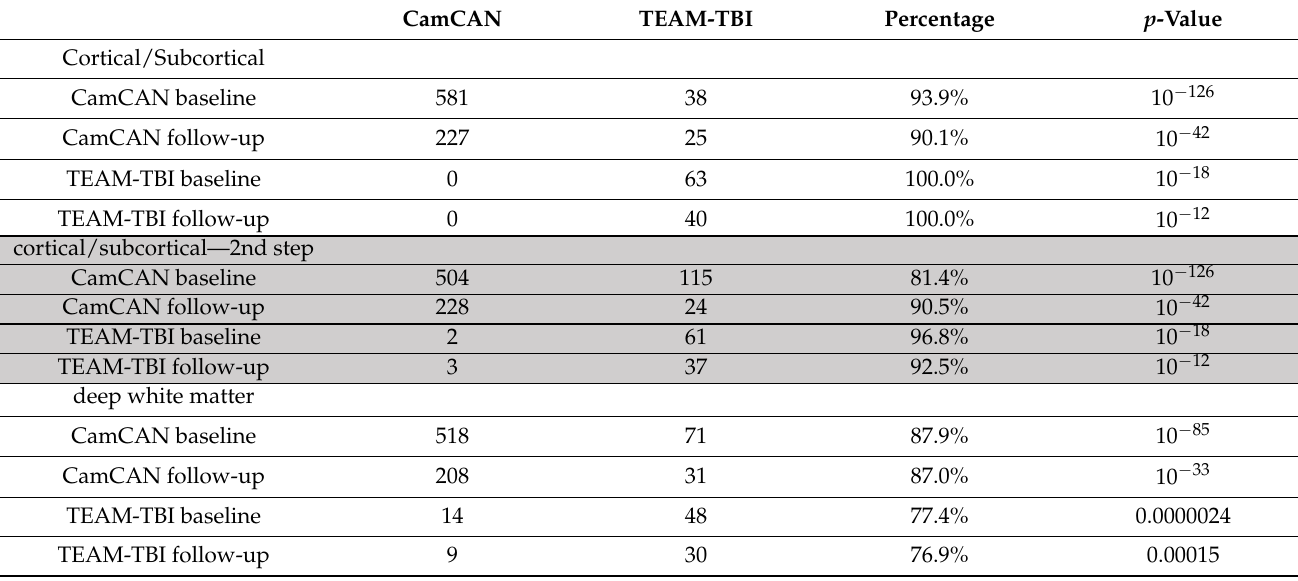
Figure 2. The classifier scores for each baseline CamCAN subject (blue, n = 589) and each TEAM-TBI subject (red, n = 63) are shown in the left . The score on the cortical/subcortical classifier is plotted on the x-axis; the score on the deep white matter classifier is plotted on the y-axis. These are the classifiers whose accuracies are shown in Table 5. In the right panel, all baseline TEAM-TBI scores are plotted, n = 63. Those who returned for follow-up ( n = 40) are plotted as arrows; the baseline is plotted at the base of the arrow; the follow-up is plotted at the arrow-head. 63 age and sex matched CamCAN subjects who returned for follow-up are plotted in blue. The standard deviation bars represent 2.0 standard deviations for the classifier scores. Table 5. 85 cortical and subcortical regional measures were trained as linear classifiers by cohort using the baseline CamCAN and TEAM-TBI measures. Jackknifed classification accuracies are shown for classifiers using 85 cortical and subcortical regions (lines 1–10) and 18 deep white matter tracts (lines 11–15). The results highlighted in gray were obtained when the regions which were selected for the first classification analysis were excluded. See the text for